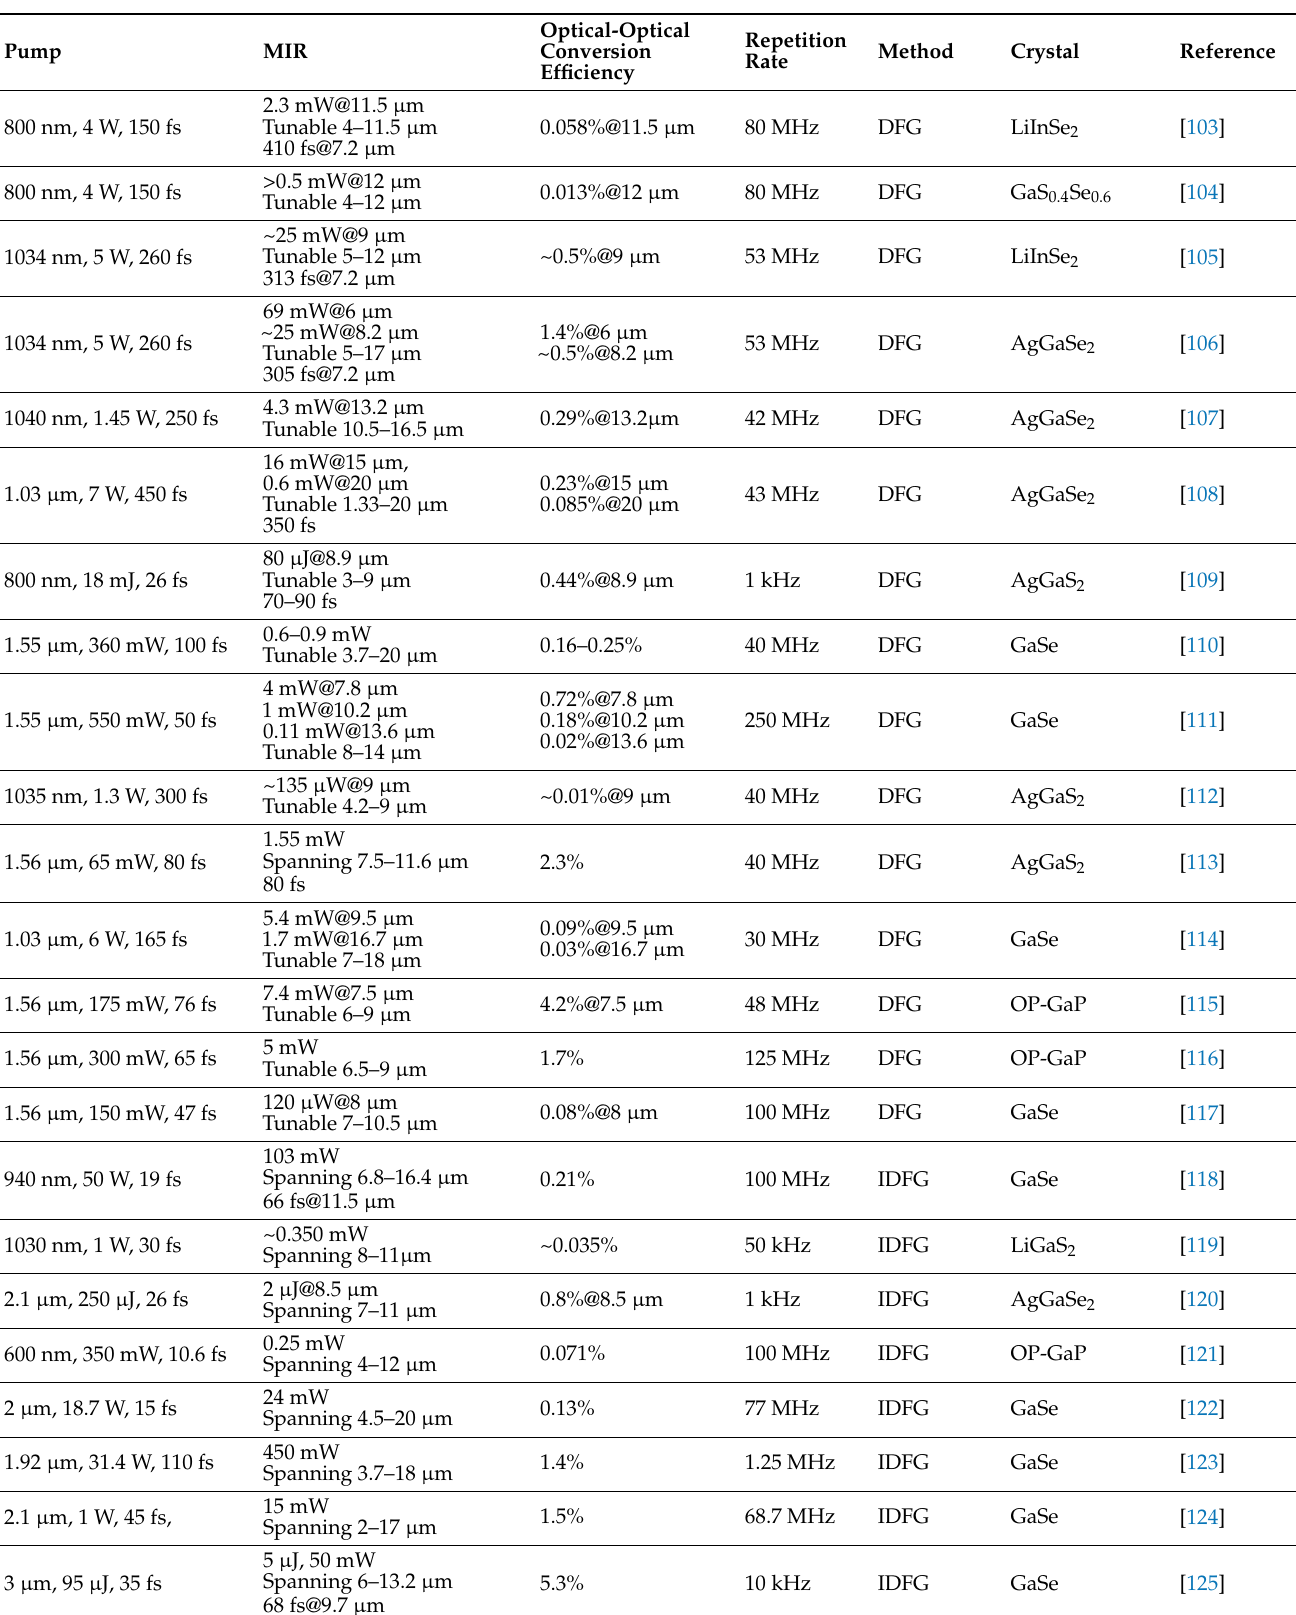
Table 1. Studies on the generation of ultrafast MIR sources above 8 µ m based on DFG and IDFG [118–135]. Optical-Optical MIR